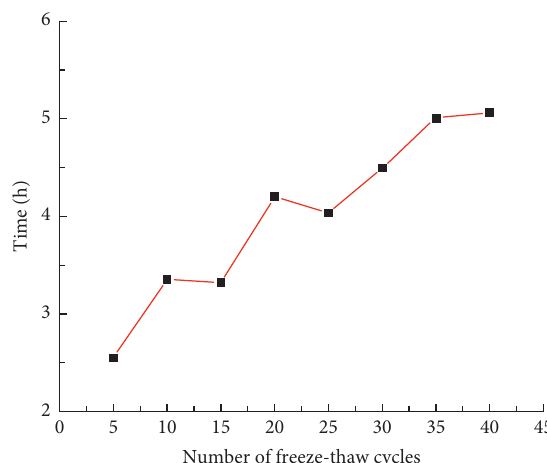
Figure 9: Time required for the initial freezing phase as a function of the number of freeze-thaw cycles.